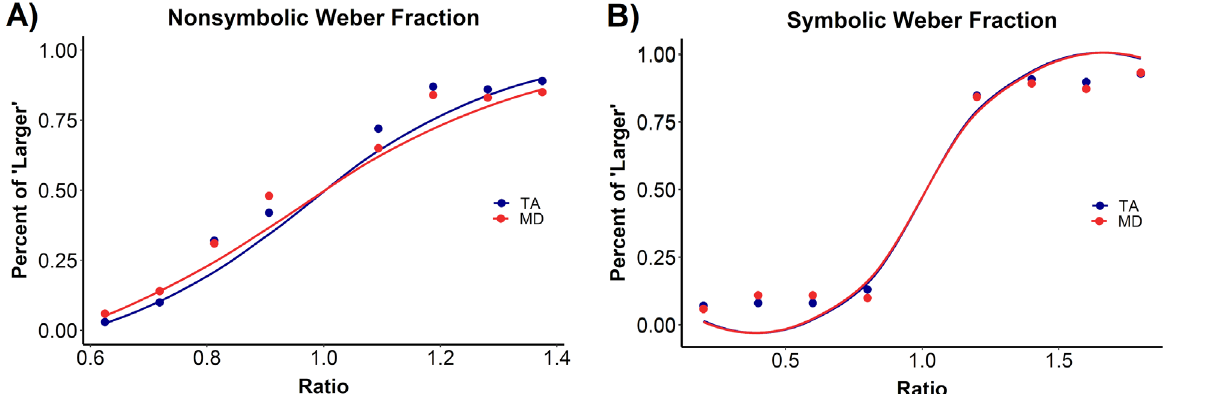
Figure 2. The weber fraction of children with typical achievement (TA, in blue) and mathematics difficulties (MD, in red) in (A) the nonsymbolic numerical magnitude comparison task and (B) the symbolic numerical magnitude comparison task. There was a significant group difference in nonsymbolic weber fraction (i.e., lower performance in the MD group). However, groups did not differ in the symbolic weber fraction.